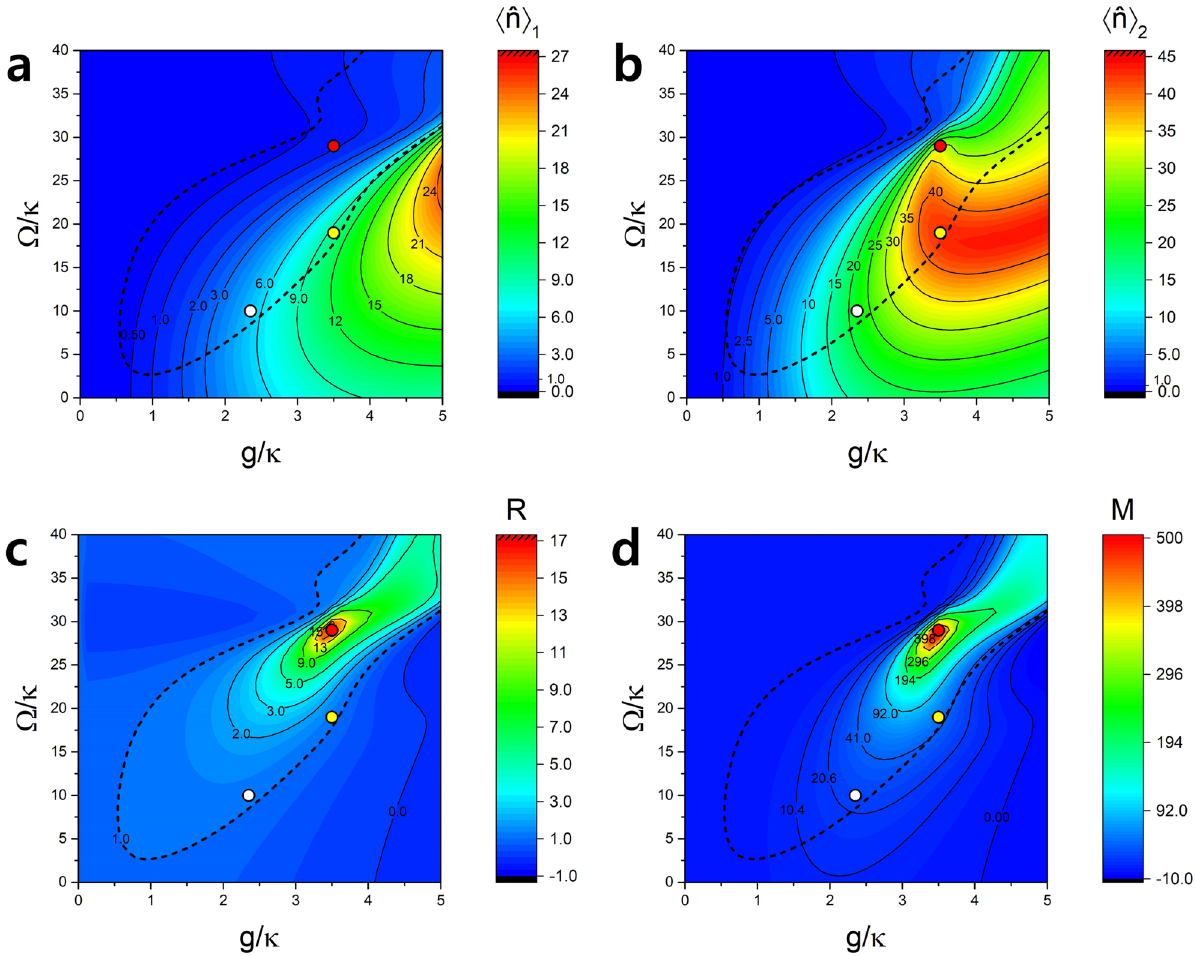
Figure 6. Magnified view of the low g region. ( a ) Average number of photons in the cavity for one-atom 0.052 /κ , 1 /κ 1.93 µ s and case. ( b ) The same for two-atom case. ( c ) Radiance witness R . Parameters are τ = = φ π/ 2 . Hyperradiance region is inside the black dashed lines. We obtained the maximum mean photon = 3.5 with 1.19 19 and g /κ 43 in two-atom case at around �/κ 9.78 and R n n number 2 1 = = = �ˆ � ≃ �ˆ � = 2.35 (experimentally more easier to access) and (indicated by yellow dots). The white dots correspond to g /κ = 1.13 . The red dots are associated with the largest figure 10 , resulting in 5.19, 22.0 and R �/κ n n 1 2 = = �ˆ � = �ˆ � = 3.5 and �/κ 16.2 29 , giving rise to 30.7 and R R n n of merit M 2 with g /κ 2 = = = = × �ˆ � �ˆ � =